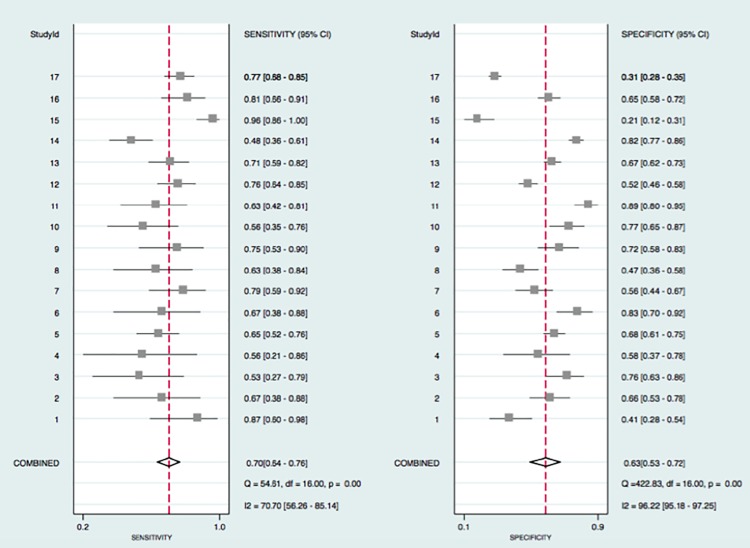
The forest plot about the pooled sensitivity and specificity for the diagnostic value of SCCa on the lymph node metastasis was drawn.And the heterogeneity could be determined on the figure. The Irawn. And the heterogeneity could be determined on the figure. SCindicating there were heterogeneity between studies.(I2>50 suggested heterogeneity existed). The pooled sensitivity was 0.7 and specificity was 0.63, indicating a medium diagnostic power.